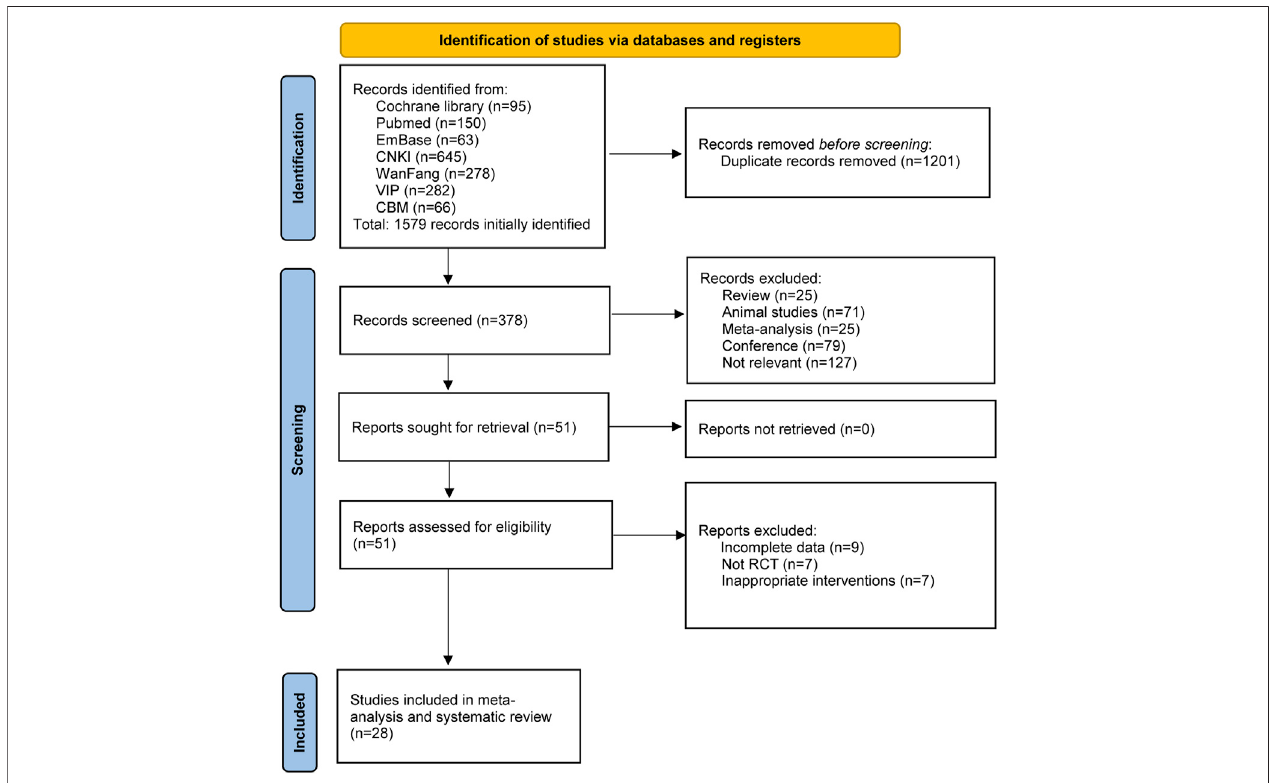
FIGURE 1 | Flowchart of literature search and selection